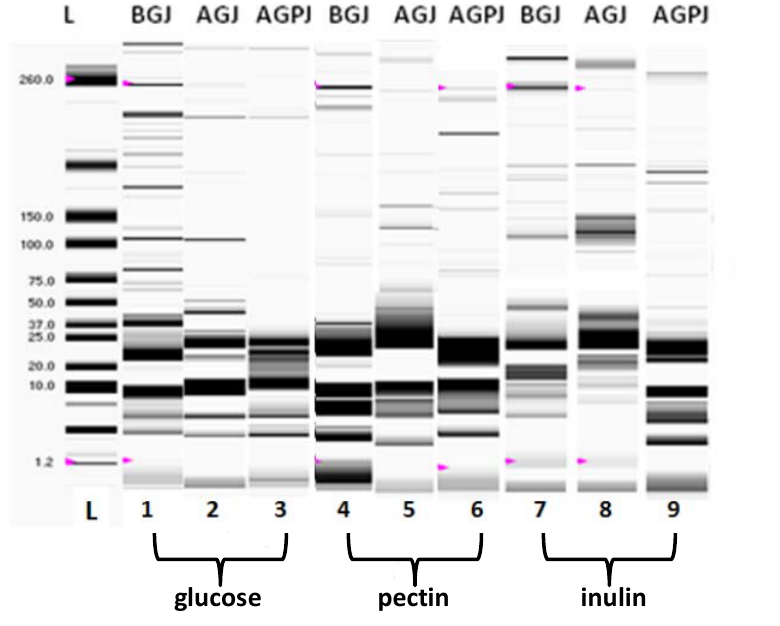
Figure 2 . The protein profile of L. plantarum subsp. plantarum grown in the presence of 20 g/L of glucose (lanes 1-3), pectin (lanes 4-6), or inulin (lanes 7-9), before (BGJ) and after passage in simulated gastric (AGJ) followed by pancreatic (AGPJ) juices. Profiles, shown as gel like data, were obtained through microelectrophoresis on chip. L indicates the MW standards (kDa). For the details, see materials and